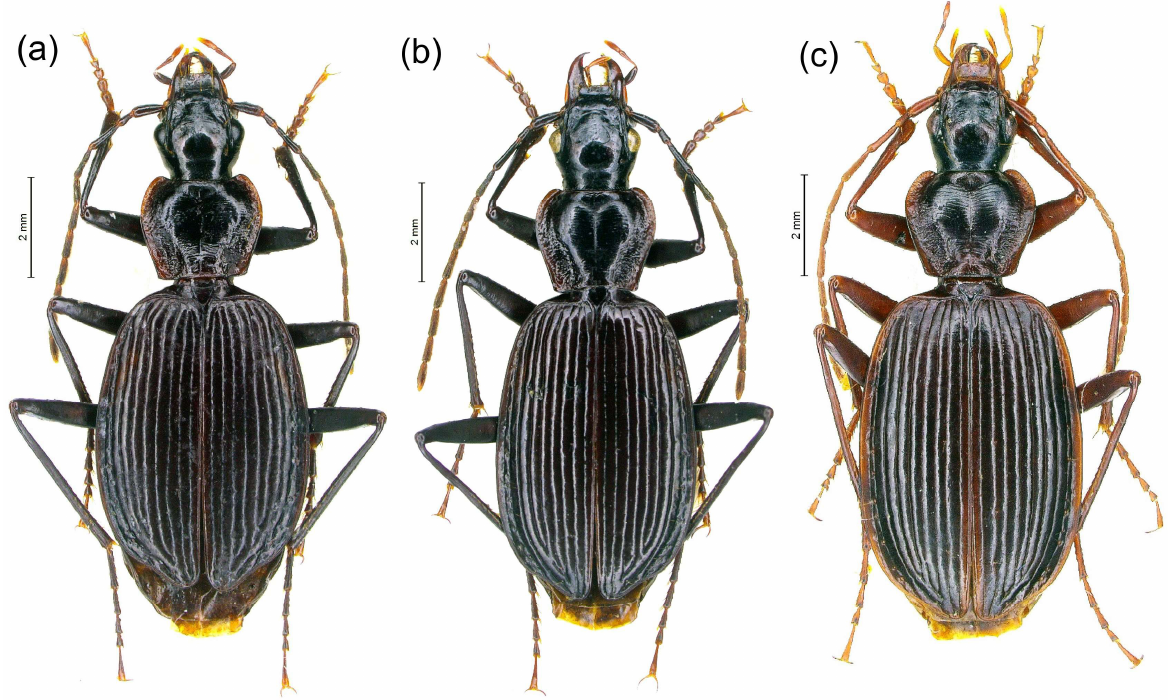
Figure 17. Habitus of Platynus species: ( a ) P. depressus ; ( b ) P. vignai n. sp. ; ( c ) P. teriolensis . Table 4. Ratio between the linear measurements of each species of Platynus . In the table, the acro- nyms correspond to: PL = pronotum maximum length, measured from anterior to the basal angle; PW = pronotum maximum width; EL = elytron maximum length, from shoulder to apex; EW = elytron maximum width; MH = maximum head width across eyes; MF = minimum frons width between eyes.